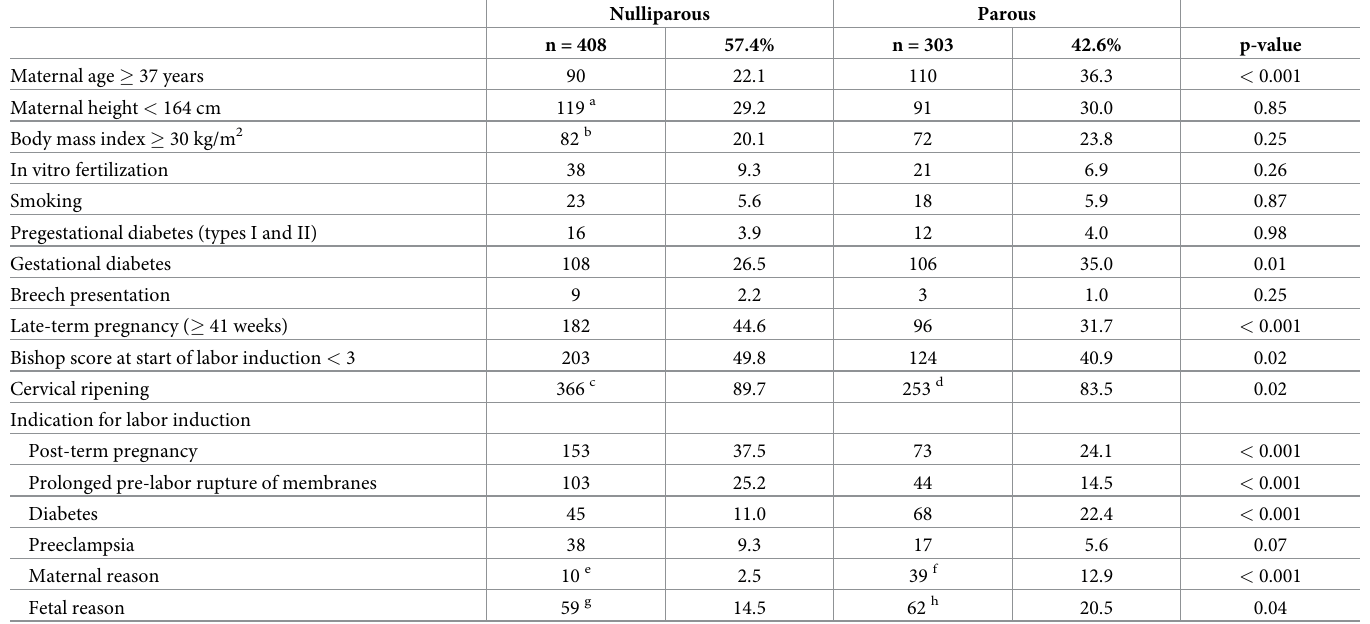
Table 1. Characteristics of the study population (N =